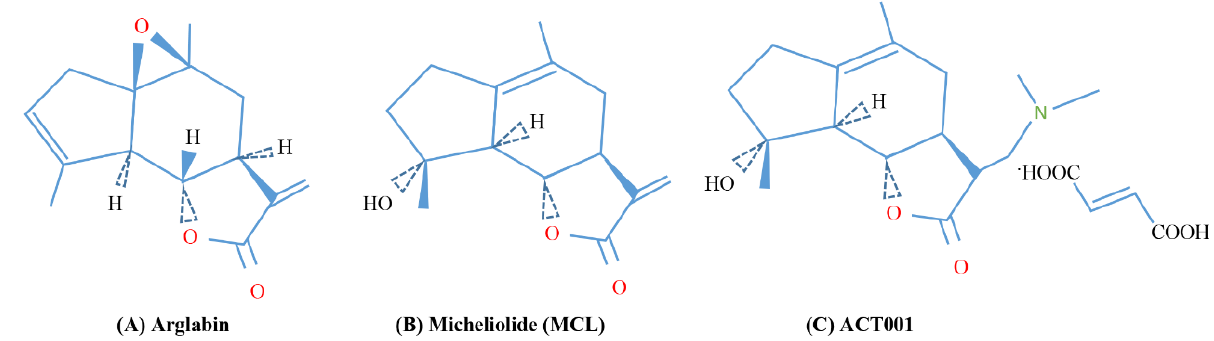
Figure 6. Chemical structures of ( A ) arglabin, ( B ) micheliolide (MCL) and its analogue ( C )